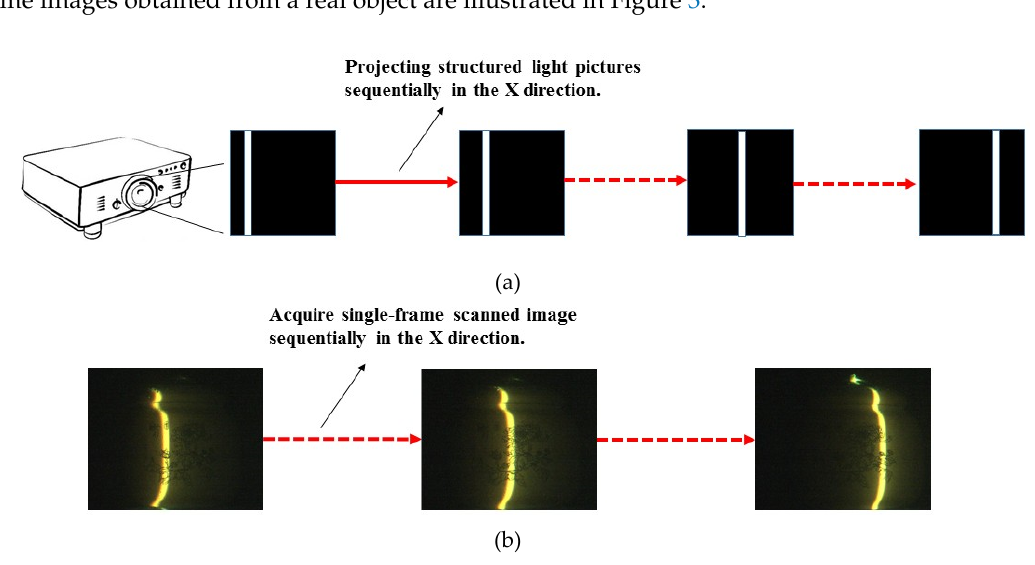
Figure 3. ( a ) Scheme of sequential illumination process. ( b ) Sequential frame images of the real object during scanning illumination.